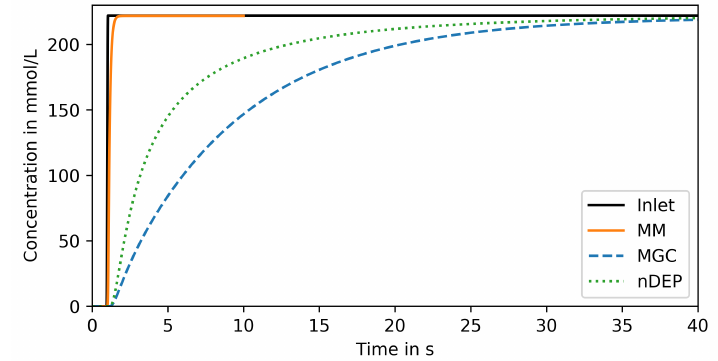
Figure 4. Reproduced signal in trapping region of compared devices for step change input.